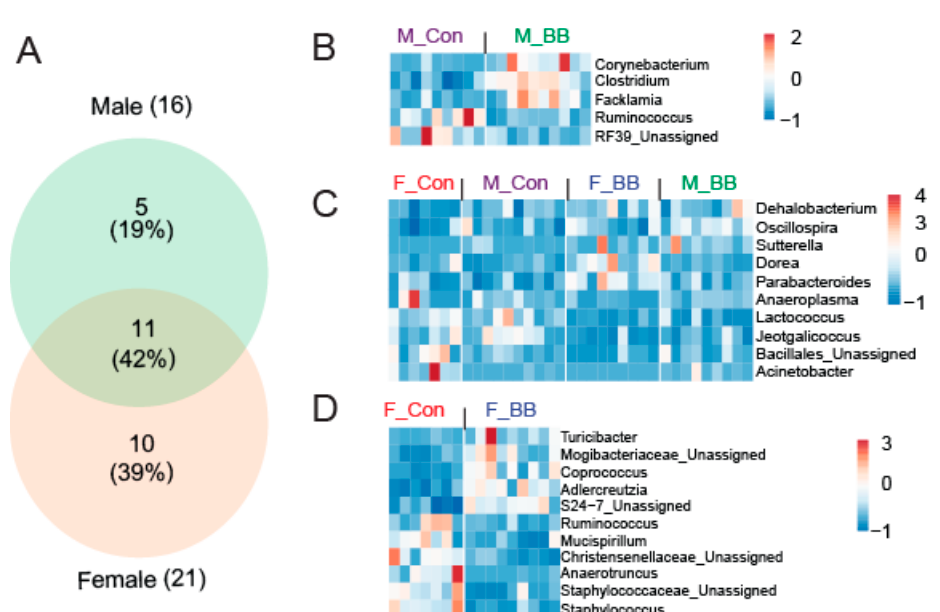
Figure 4. Blueberry supplementation affects the differential abundance of genera in a sexually-dimorphic pattern. (A) A Venn diagram showing the differential abundance of unique and common genera when determining the effect of blueberry supplementation in male and female mice. A heat map of uniquely expressed and significant genera in (B) males only, (C) males and females, and (D) in females only. F-BB (female mice fed a blueberry diet) ( n = 9), F-Con (female mice fed a control diet) ( n = 7), M-BB (male mice fed a blueberry diet) ( n = 9), and M-Con (male mice fed a control diet) ( n = 9). The color legend represents the relative fold (normalized) abundance of particular genera. The color scale shows the fold change. (Differential abundance analysis was performed using Negative Binomial Regression by taxonomic levels with pairwise comparisons of meta-data using DESeq2 workflow).